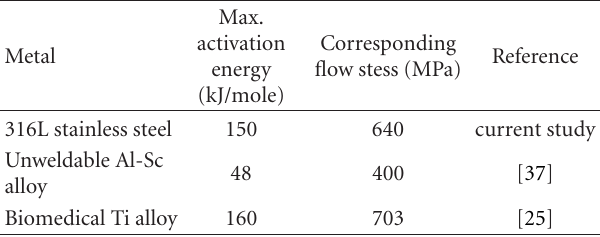
Table 5: Activation energy of various alloys at 25 ◦